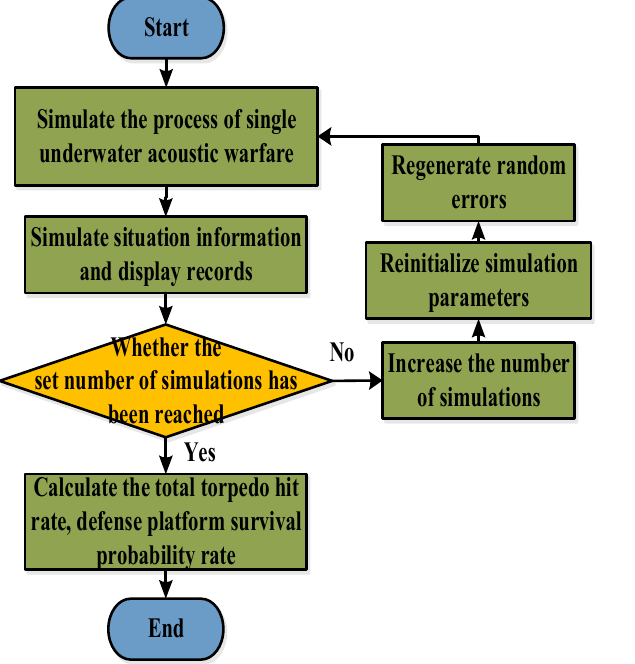
Figure 10. The efficiency evaluation module process.